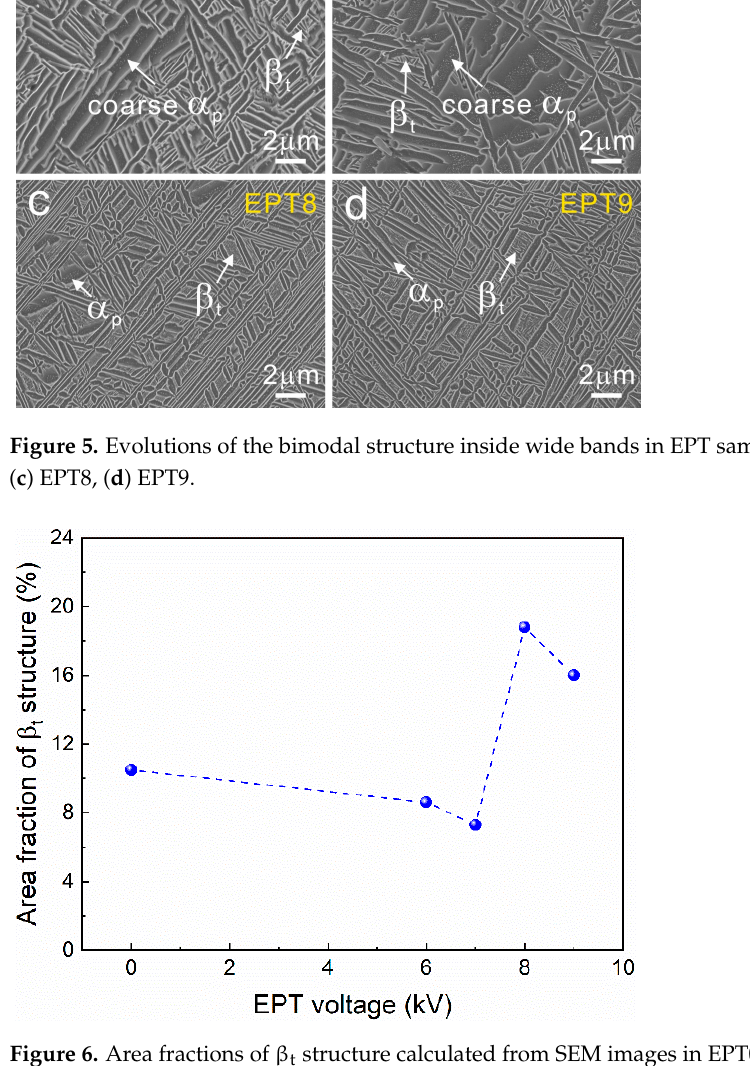
Figure 6. Area fractions of β t structure calculated from SEM images in EPT0, EPT6, EPT7, EPT8 and EPT9 samples.